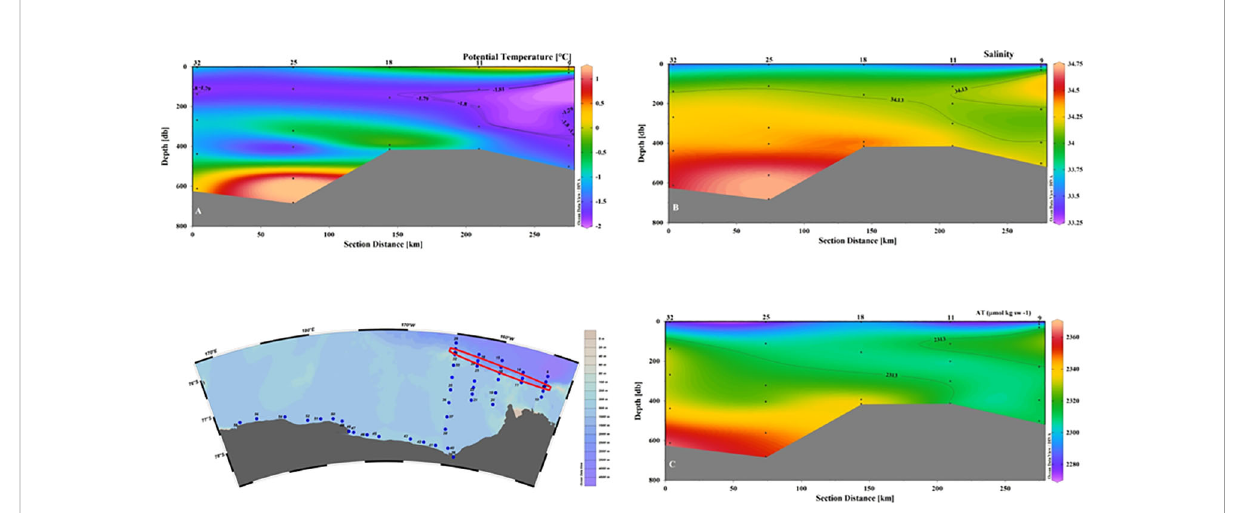
FIGURE 7 Vertical distribution of (A) Potential temperature (°C); (B) Salinity; (C) A T (µmol kg sw -1 ) for section 32-9. The values de fi ned for ASW of q , salinity and A T are shown by contour